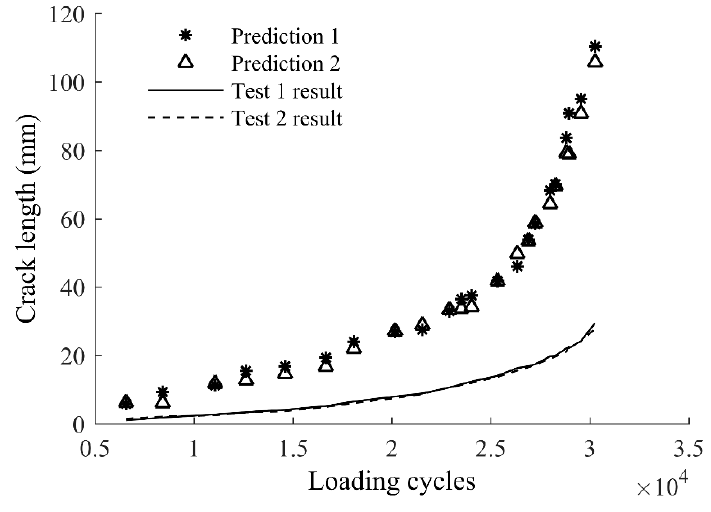
Figure 10. Baseline model predictions of crack growth for Test 1 and Test 2 and experimental results.